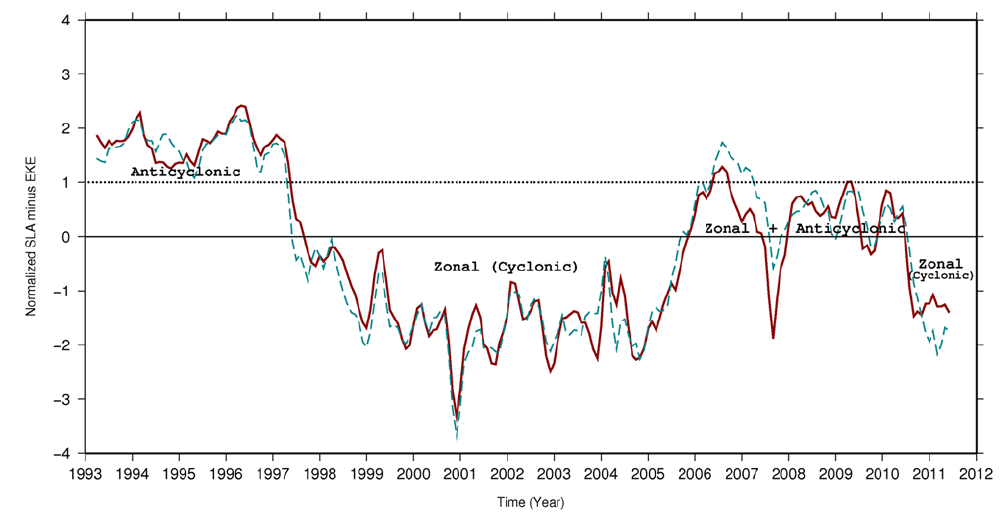
Fig. 16. Time series of mean standardized SLA minus mean standardized LF-EKE in previously defined respective boxes in the Ionian region during the period 1993–2011: average in boxes S1 and E1 + E2 + E3 + E4 + E5 (red line) and average in S1 and E2 + E3 + E4 (blue dashed line). Level 0 and level 1 have been mentioned in order to differentiate surface circulation